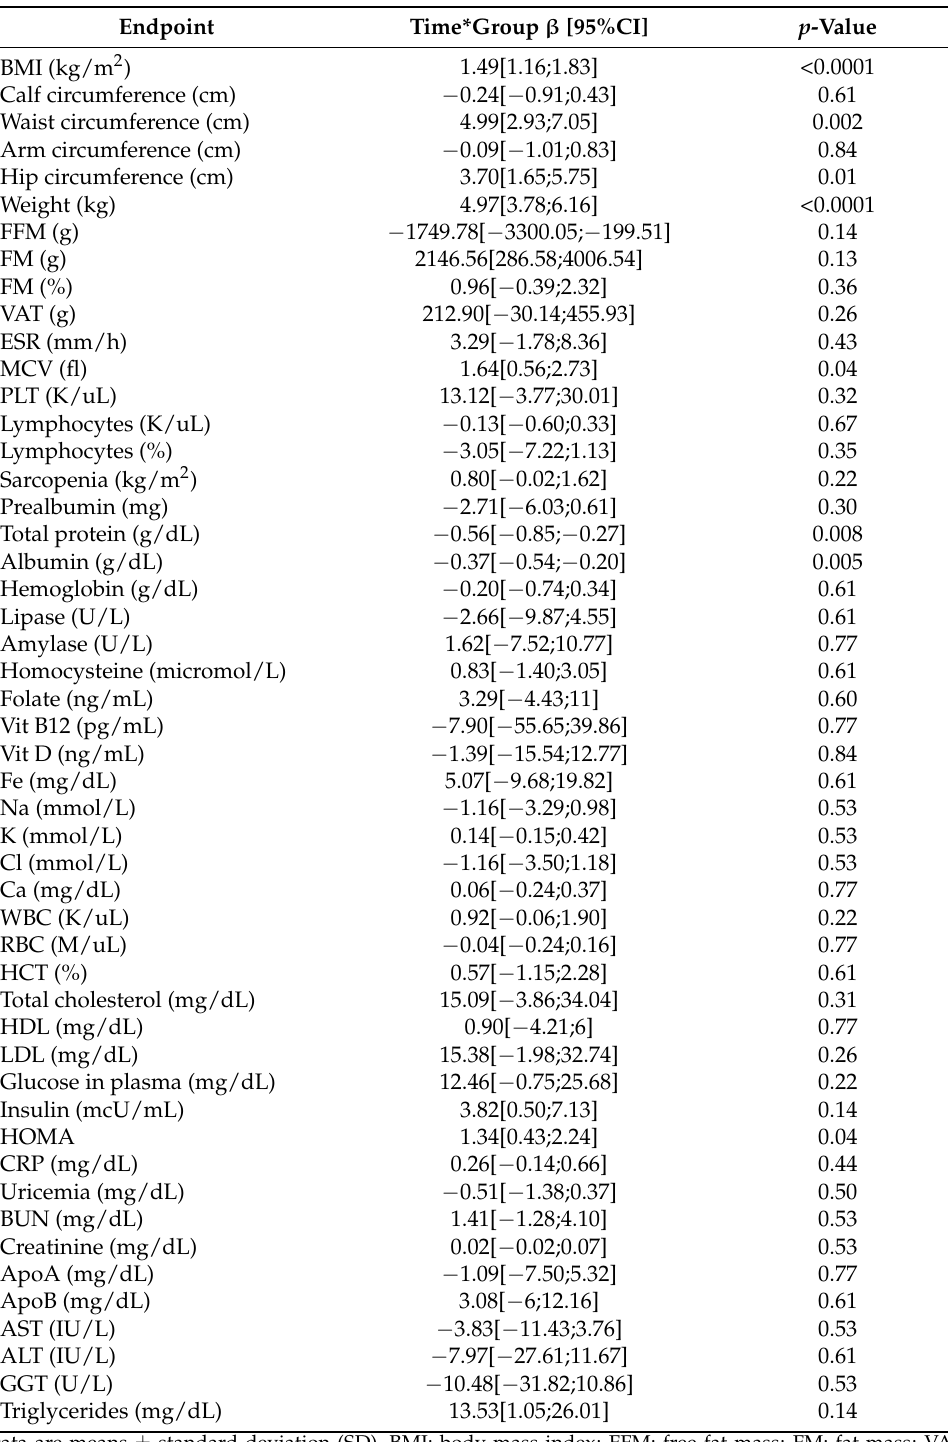
Table 5. Between-group differences for anthropometric, body composition, and biochemical mea- surements. Estimates of time*treatment β , 95% confidence intervals (CI), and adjusted p -values of the null hypothesis of β = 0 are reported for each